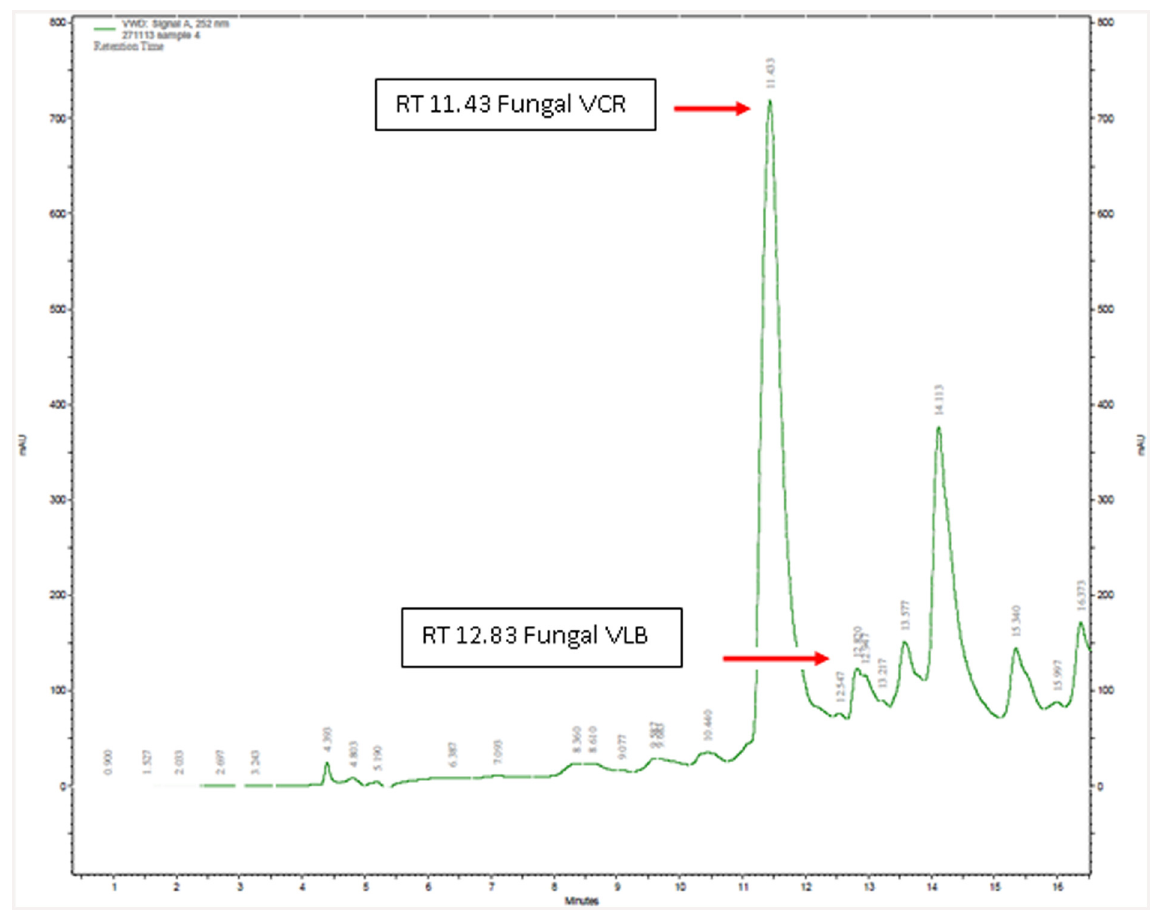
Fig 11. HPLC profile of T . radicus — CrP20 culture extract showing VCR (RT-11.43) and VBL